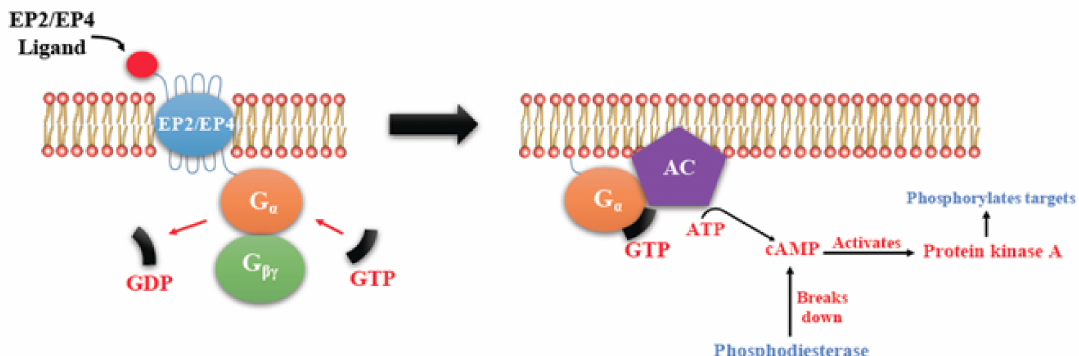
Figure 4. Shared pathway of EP2/EP4 mediated Signaling. There is activation of adenylyl cyclase (AC) leading to a rise in the second messenger cAMP in the cytosol that activates Protein kinase A (PKA). PKA in turn activates a transcription factor CREB (cAMP response element-binding